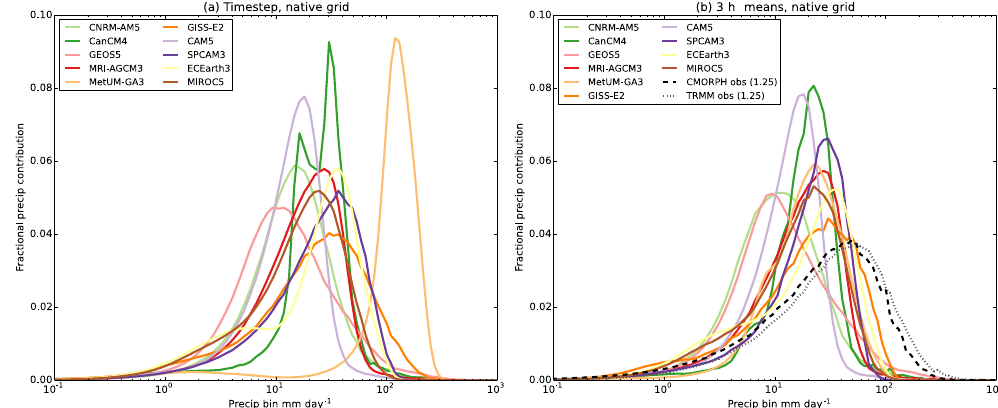
Figure 8. For the GASS/YoTC models, histograms of the fractional contributions from each precipitation bin (defined in Eq. 1) to the total precipitation, computed across 60–160 ◦ E, 10 ◦ S–10 ◦ N, using data on the native horizontal grid and (a) time step and (b) 3h averages. Panel (b) includes TRMM 3B42 and CMORPH at 1.25 ◦ resolution for the same region and time period as the GASS/YoTC models.